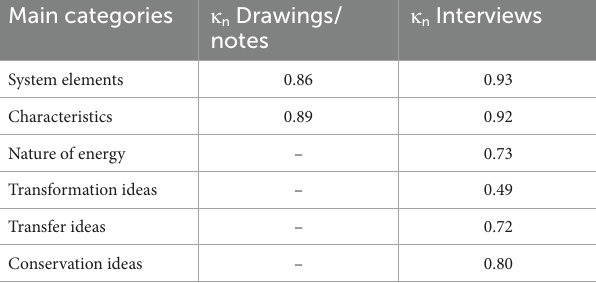
TABLE 2 Intercoder reliabilities for the main